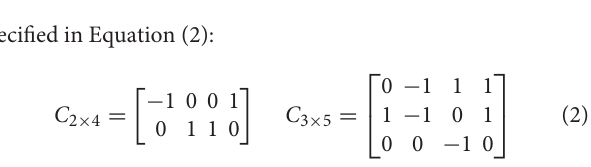
15,000. (B) Shows the L1 distance between the centroid of every run at time t and the = 15,000, for all M 4, N 2 matrices. (C) Shows the effective number of states over time, for 1,000 runs of the same M = = = 4, N 2 matrices. (E–H) Show the same analysis, for M = =